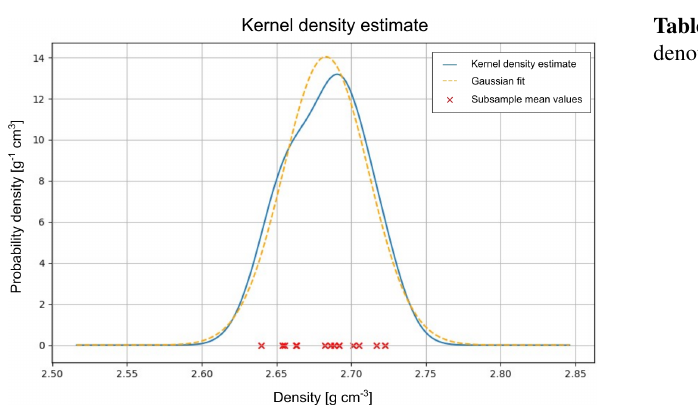
Figure B2. Example output of “materializer.py”. Here, a set of sub- sample mean values (red crosses) is processed in a kernel density estimate (solid blue line). Finally, a normal distribution is fitted to the kernel density estimate (dashed yellow line).